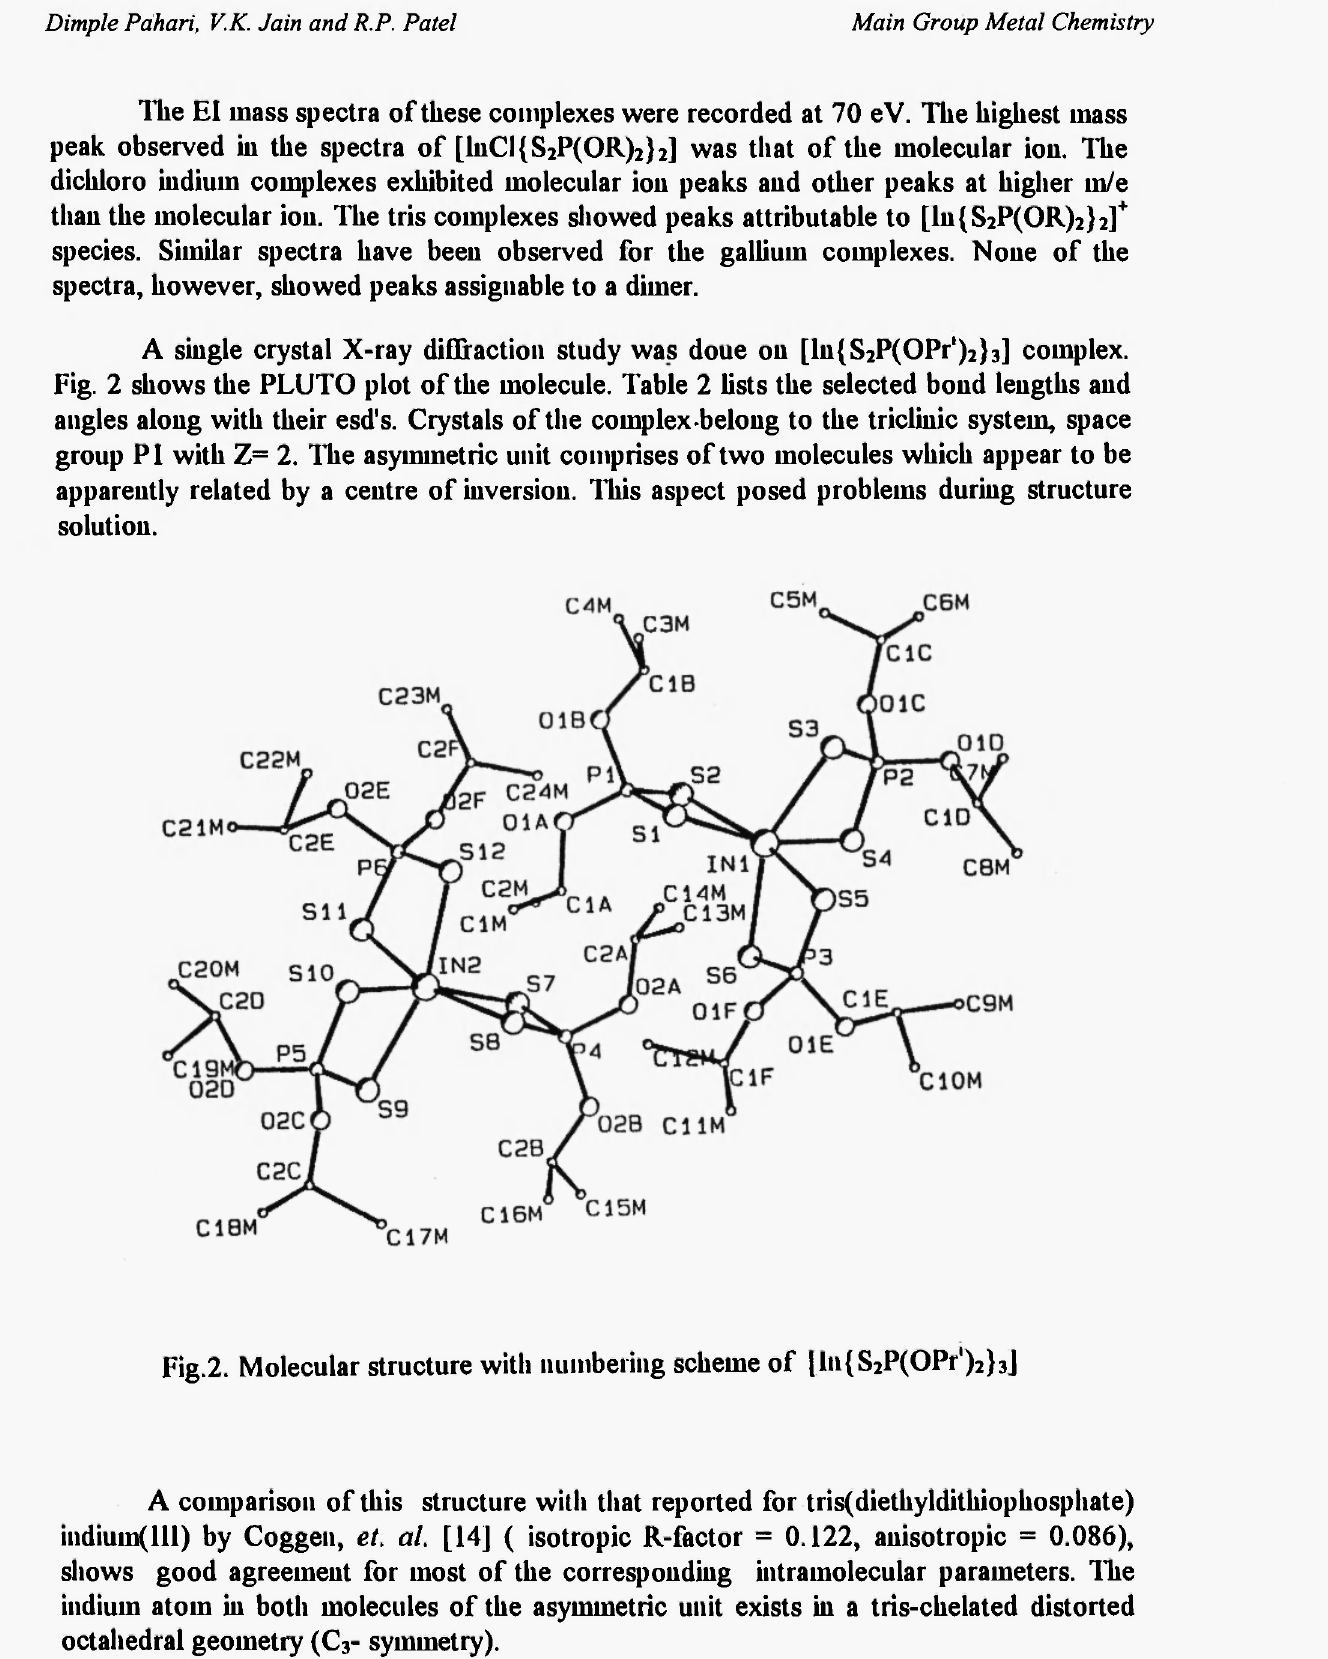
Fig.2. Molecular structure with numbering scheme of |hi{S